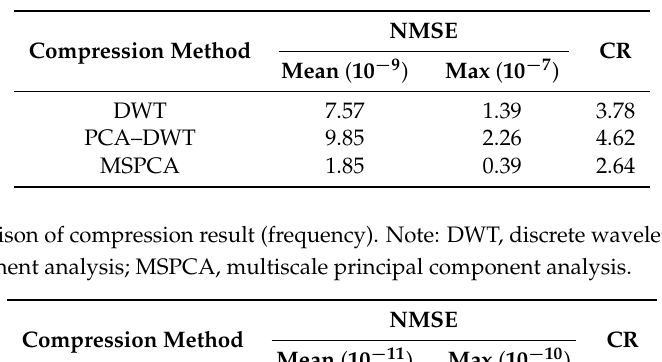
Table 4. Comparison of compression result (voltage). Note: DWT, discrete wavelet transform; PCA, principal component analysis; MSPCA, multiscale principal component analysis.